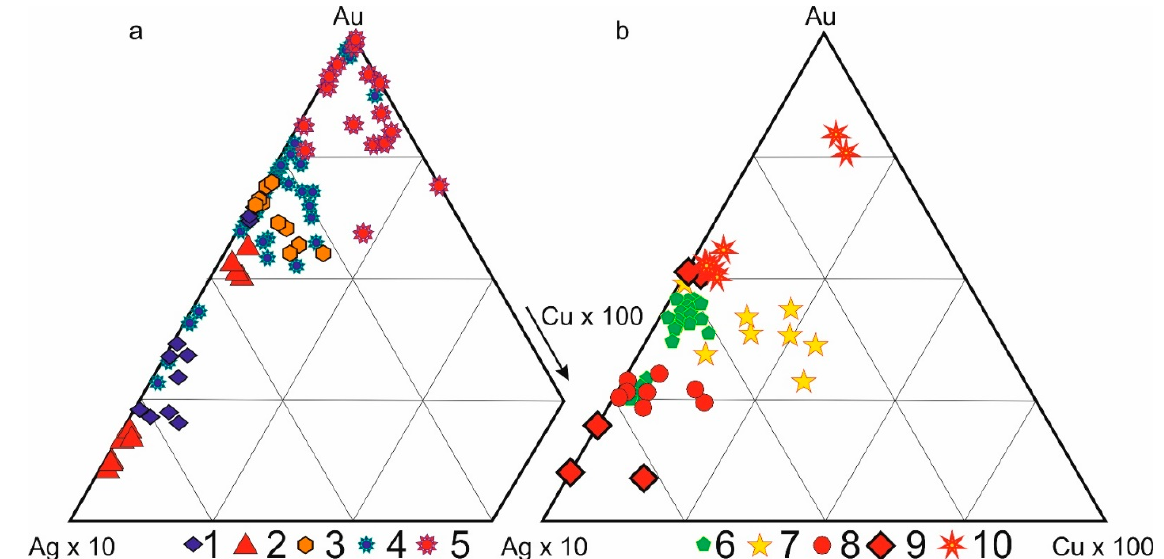
Figure 12. Ternary diagrams [19] for the native gold from different ore types in the Vorontsovskoe deposit ( a ) and other deposits in the Turyinsk-Auerbakh metallogenic province ( b ): 1—jasperoids [6]); 2—skarns [6]; 3—medium-temperature metasomatites developed on tuffs and tuffstones [6]; 4—gold from realgar-orpiment cement of ore breccia (this data); 5—gold from ore breccia [6]; 6—the skarns of the Dorozhnoe ore occurrence [9]; 7—the bornite-chalcopyrite exo- and endoskarns of the Bashmakovskoe deposit (19); 8—medium-temperature gold ore metasomatites on tuffstones (authors’ data); 9—the chalcopyrite-pyrrhotite ores of the Bogoslovskoe deposit [21]; 10—the pyrite mineralization of the iron-skarn Yuzhno-Peshchanskoe deposit [21].